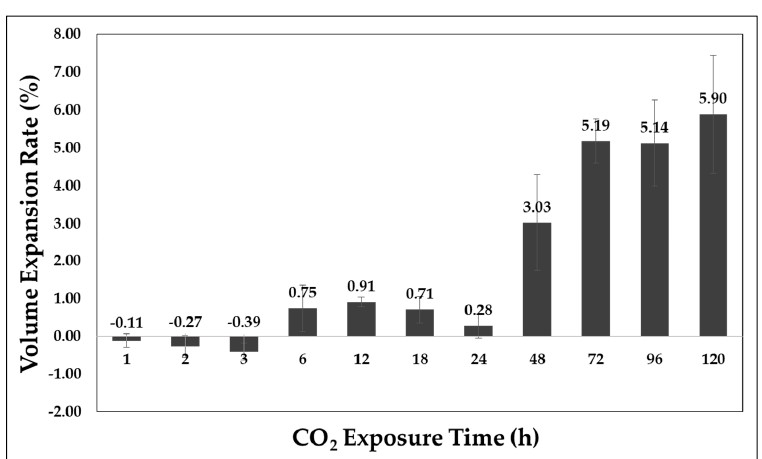
Polymers 2019 , 11 , x FOR PEER REVIEW Figure 8. Adsorption rate according to adsorption time. Figure 8. Adsorption rate according to adsorption time.